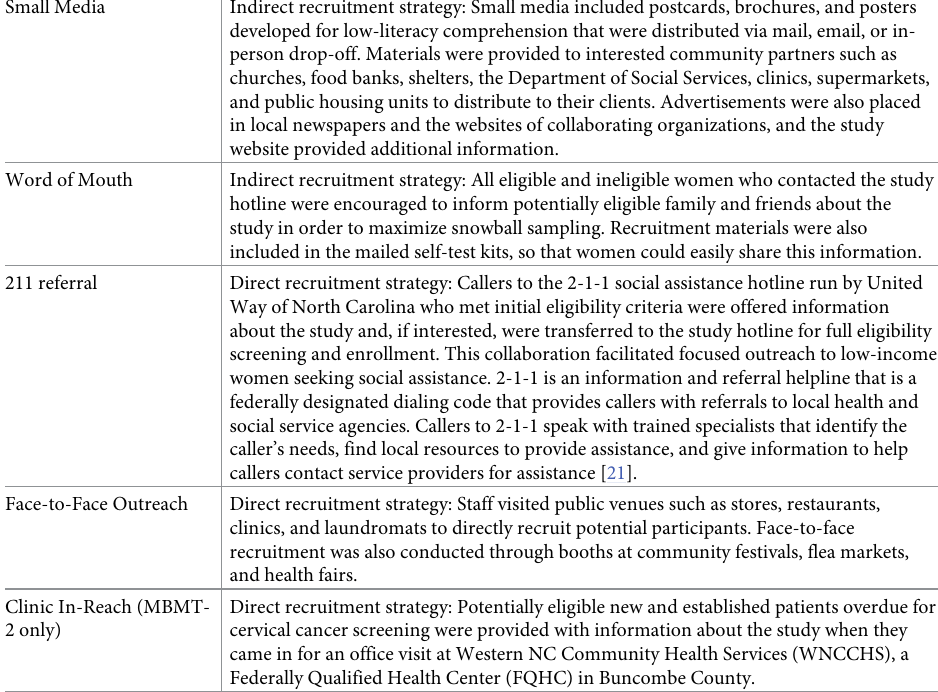
Table 1. Definitions of recruitment